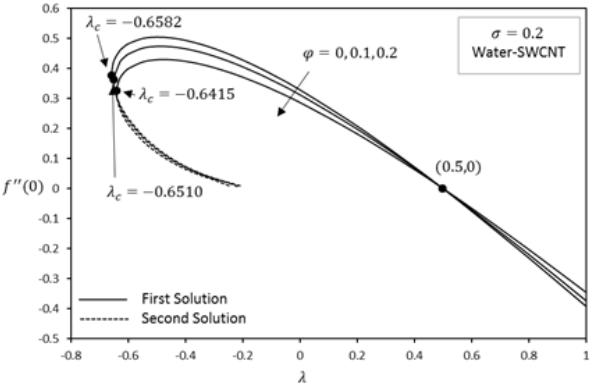
Figure 2. Effect of ϕ on reduced skin friction ( ) 0 f ′′ .